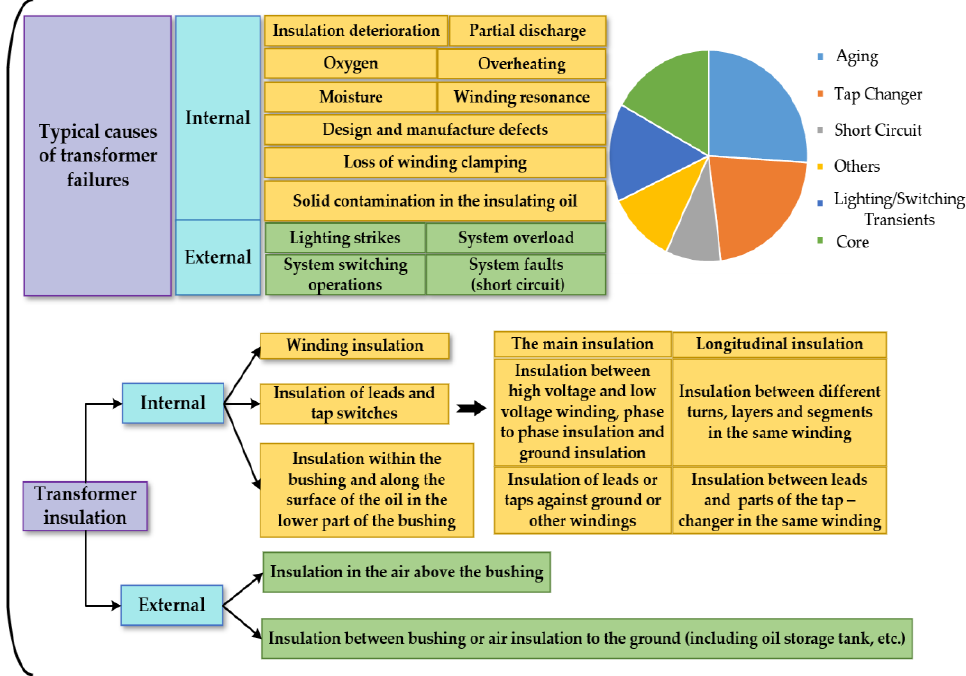
Figure 1. Main factors of transformer failure and typical insulation types.